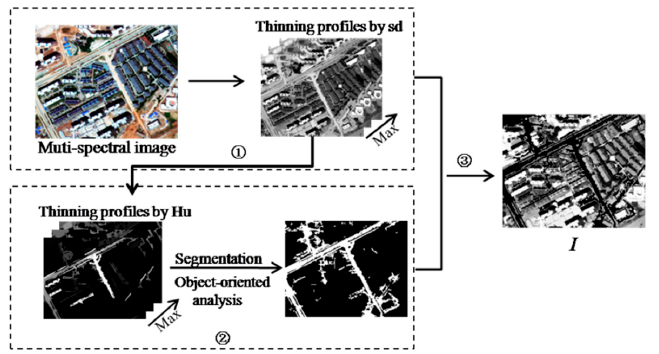
Figure 3. Pre-processing Figure 3. Pre ‐ processing flowchart.